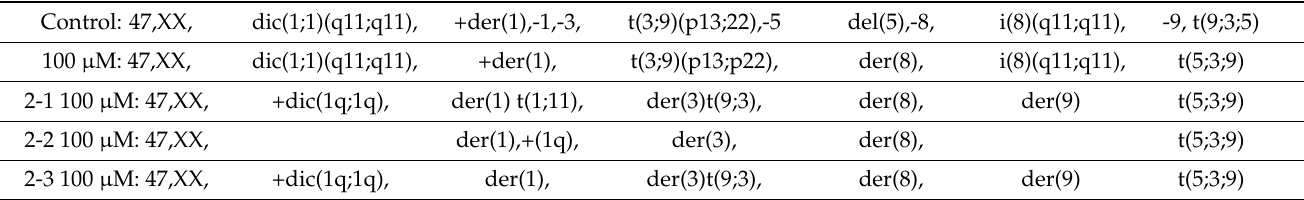
Figure 3. Anchorage Independent Growth in Soft Agar. ( A ) 6-well cell culture plates were prepared with a bottom layer consisting of 0.5% agarose in SIT medium with 5% FBS added. The top layer included 50,000 cells suspended in 3 mL of 0.3% agarose in SIT medium. Black arrows show an acini-like spheroid with hollow lumen formed by control MCF10A cells. White arrows show a clustered and disorganized spheroid formed by MCF10A cells previously maintained in 100 µ M DETANO. ( B ) * p < 0.05 significantly increased colony formation in soft agar, when compared to untreated control. Table 1. Karyotype Analysis